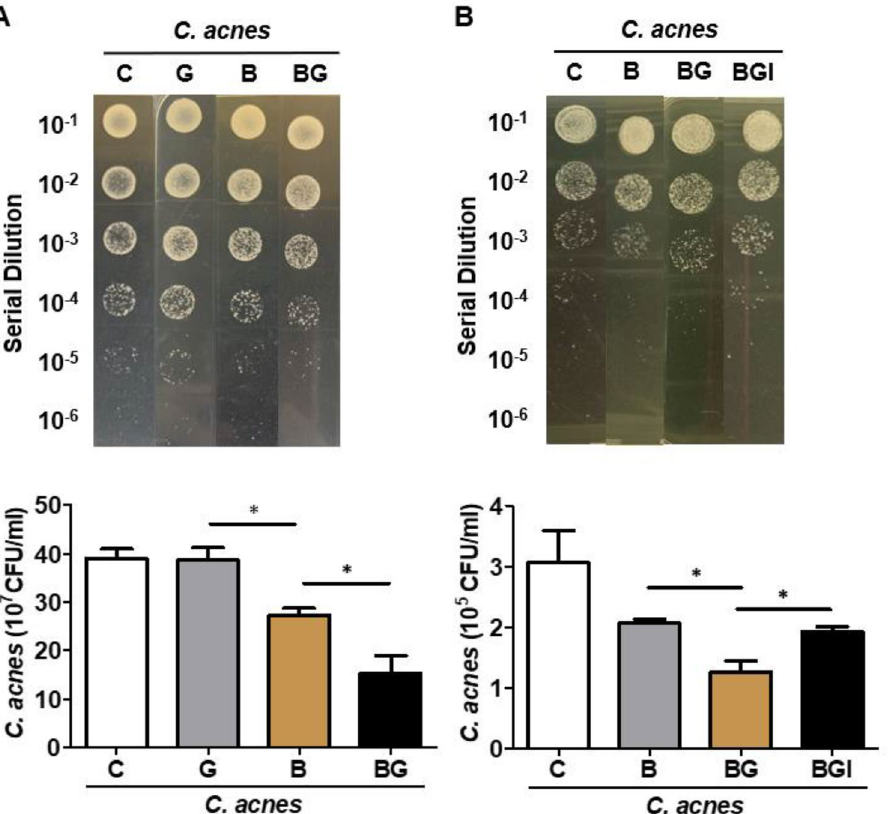
Figure 3. B. circulans fermentation with glucose affect C. acnes growth in vitro and in the presence of roseoflavin in vivo. ( A ) In vitro, the C. acnes (CFU) was assessed by enumerating a plating serial dilution (1:10–1:10 5 ) on selective agar containing RCM agar plus furazolidone. ( B ) The CFU of C. acnes was assessed in B. circulans with glucose in the presence of roseoflavin (BGI) in vivo. C. acnes mix with PBS (C), glucose (G), B. circulans (B), and B. circulans plus glucose (BG) was included. Data are expressed as the mean ± SD of three separate experiments. * p <